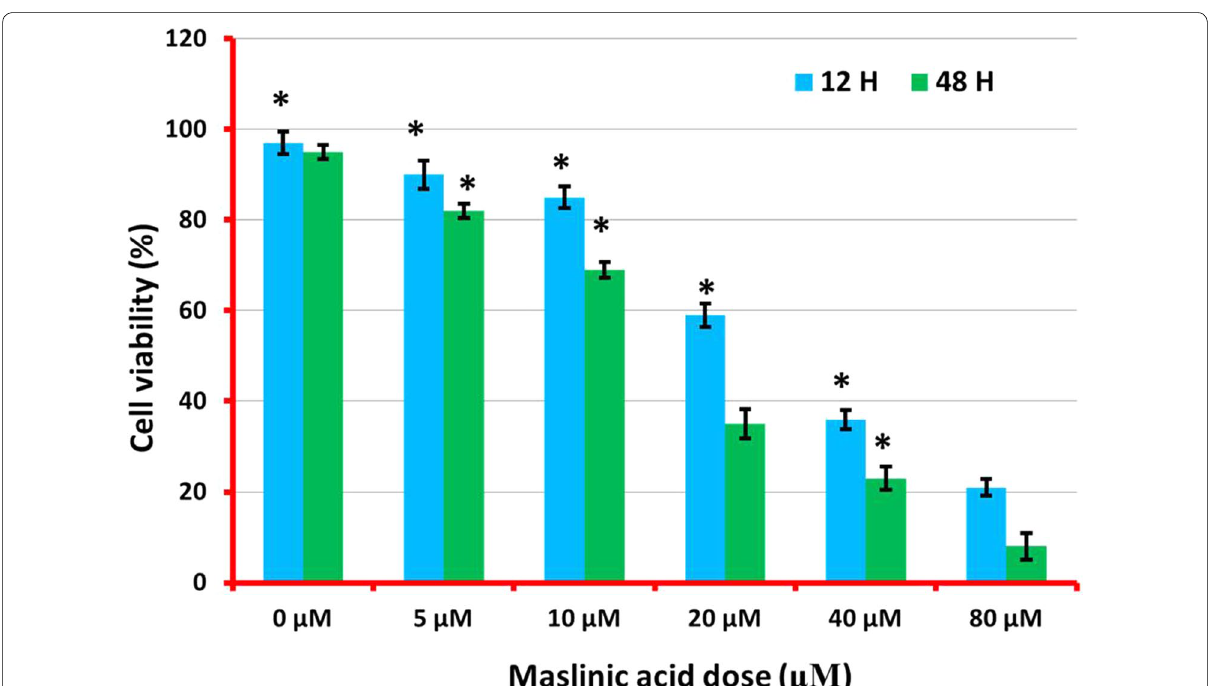
Fig. 2 Valuation of proliferation rate in maslinic acid treated neuroblastoma SHSY-5Y cell line was achieved through accomplishment of MTT assay at indicated concentration and time intervals. The results depicting noteworthy suppression in proliferation of SHY-5Y cells in dose- and time-reliant manner as indicated. All the data indicated in this figure are represented as mean SD and p < 0.05 was considered as statistically ±